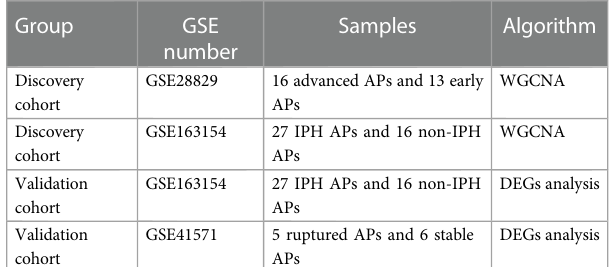
TABLE 1 Datasets grouping information.